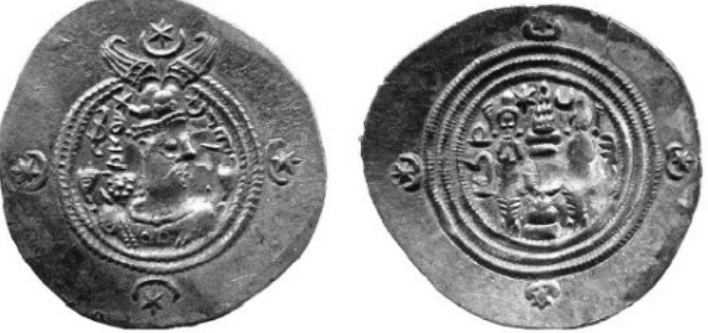
Figure 7. Khosrow II‘s coin ‐ type II, impression on silver, 591, Tehran, National Museum of Iran. The third group of coins dating back to the eleventh and twelfth years onwards reflects minor changes. Here, the headgear of the attendants on the reverse was changed from a bonnet to a crown; this particular type of iconography became the prevalent model from year 12 to year 39 (i.e., the last year of Khosrow’s rule). Although the iconography of Sasanian coins on the obverse symbolized the victories of the ruling king and his increased glory [59] (p. 68), depictions on the reverse convey religious meanings (also, see [21], in particular chapters 6, 7, and 8). The fire altar, which is the main part of the reverse side of Sasanian coins, eloquently refers to Zoroastrianism [44] (p. 45). Soudavar reads the